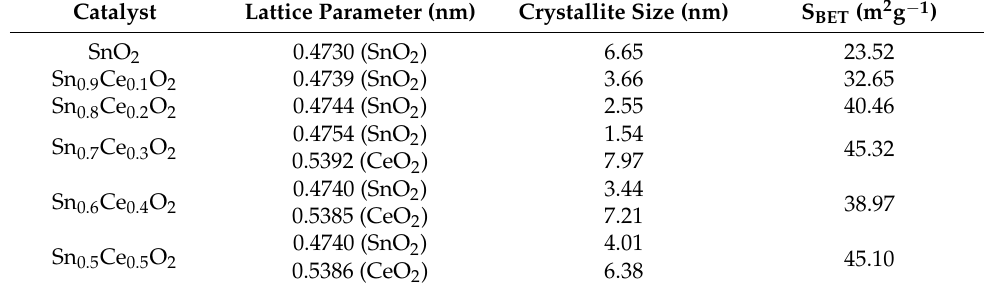
Table 1. Phase composition, lattice parameters, crystallite size, and specific surface area of the SnO 2 and Sn x Ce 1 − x O 2 fiber catalysts.